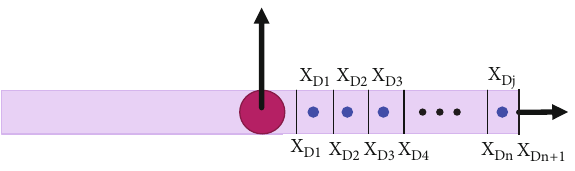
Figure 5: Disperse the fi nite-conductivity fracture.